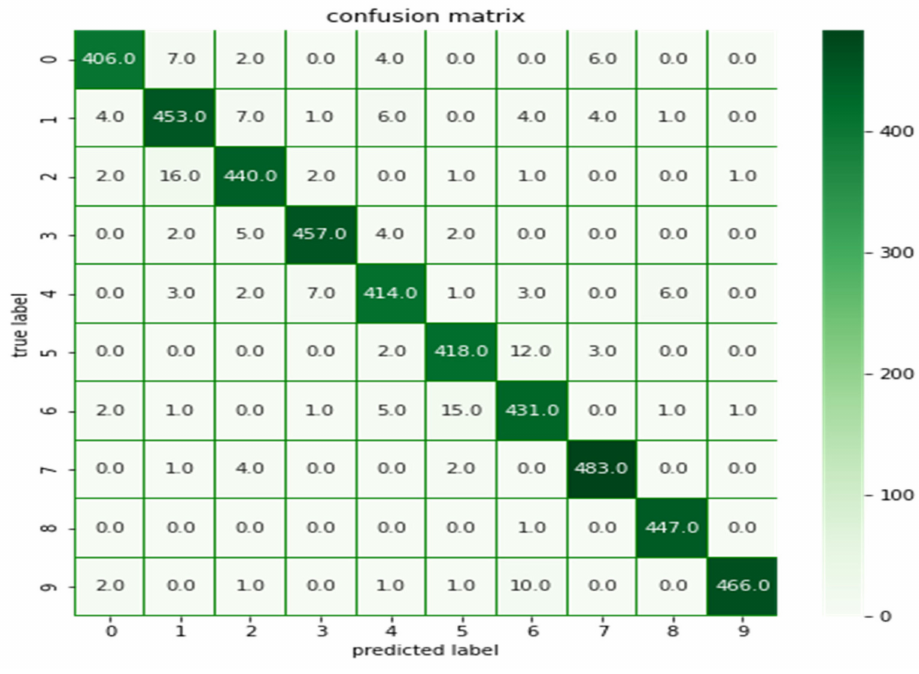
Figure 7. The Confusion